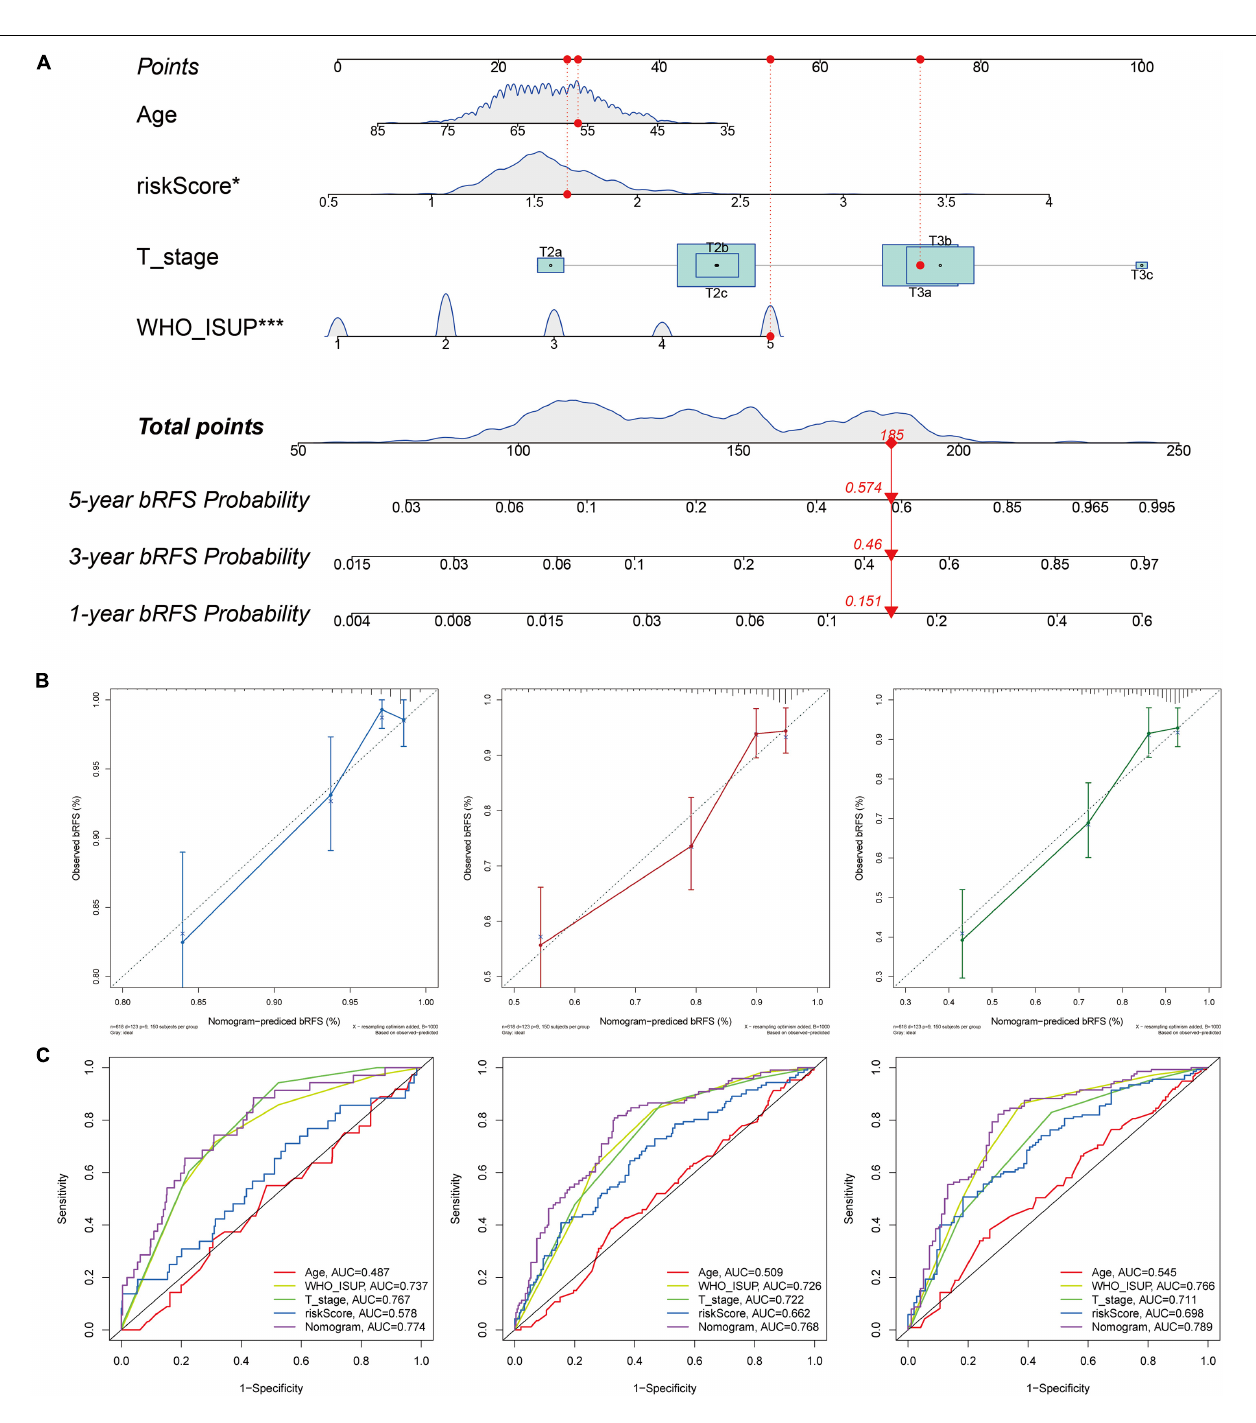
FIGURE 10 | Nomogram for bRFS prediction. (A) A prognostic nomogram including signature risk score and other clinical factors. For example, a patient with an age of 56.37, WHO ISUP of 5, a T stage of T3a, and a signature score of 1.6597 had a total nomogram score of 185, implying the 1-, 3-, and 5-year bRFS probability of 15.1, 46, and 57.4%, respectively. (B) The calibration curves of the 1-, 3-, and 5-year bRFS. (C) ROC curve used to evaluate the 1-, 3-, and 5-year bRFS predictive efficiency.